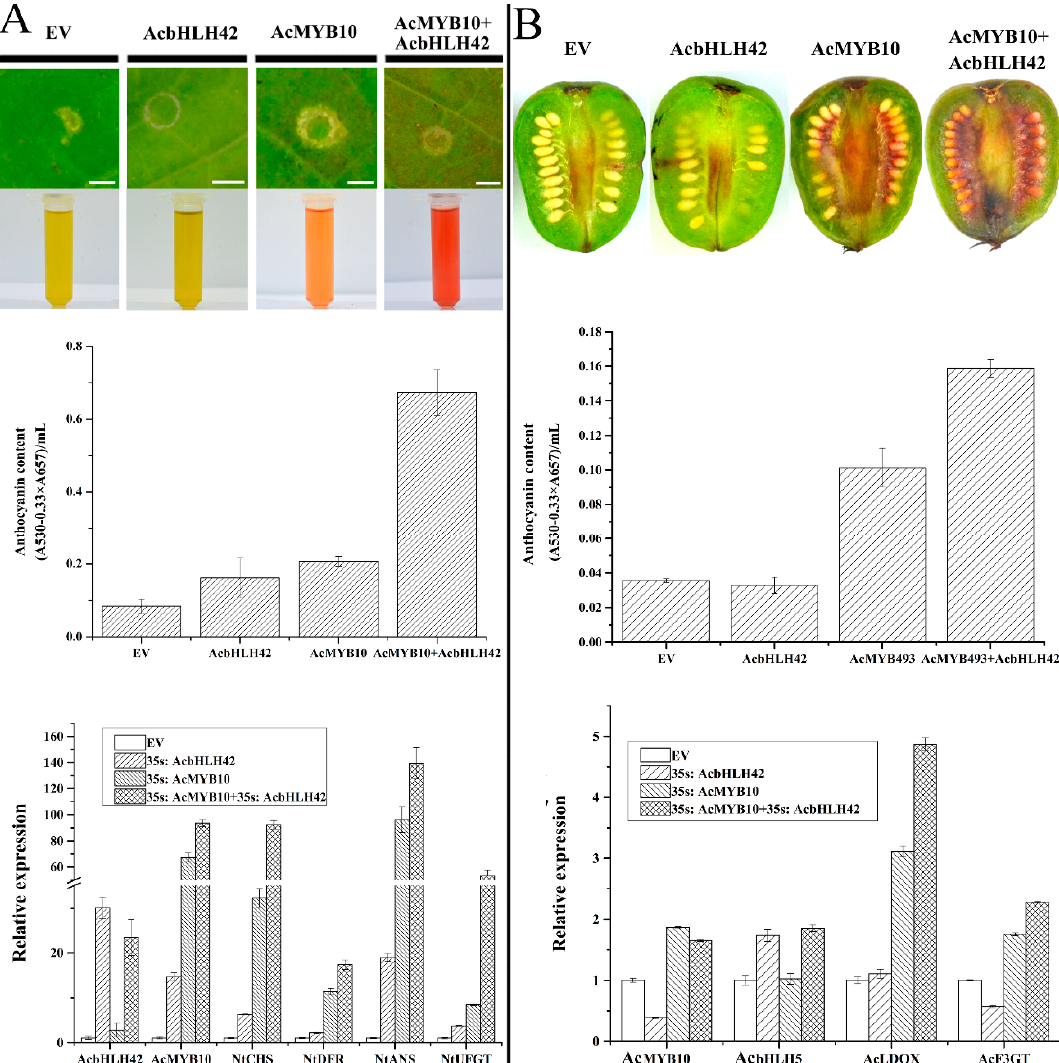
Figure 10. The combinatorial action of AcMYB10 and AcbHLH42 determines anthocyanin production in transiently expressed N. tabacum leaves and A. arguta. Color changes induced by transiently expressing either 35S:AcMYB10 or 35S:AcbHLH42 alone, or co-expressing 35S:AcMYB10 and 35S:AcbHLH42 in ( A ) N. tabacum leaves and ( B ) A. arguta fruit. The liquid in test tubes are fresh extracts from the individual infiltrated patches. The bar scales are 4 mm. Total anthocyanin content measured in ( A ) N. tabacum leaves and ( B ) A. arguta fruit. Anthocyanin content was determined 6 days after infiltration. Expression analysis of AcMYB10 , AcBHLH42, and key anthocyanin biosynthesis genes in ( A ) N.